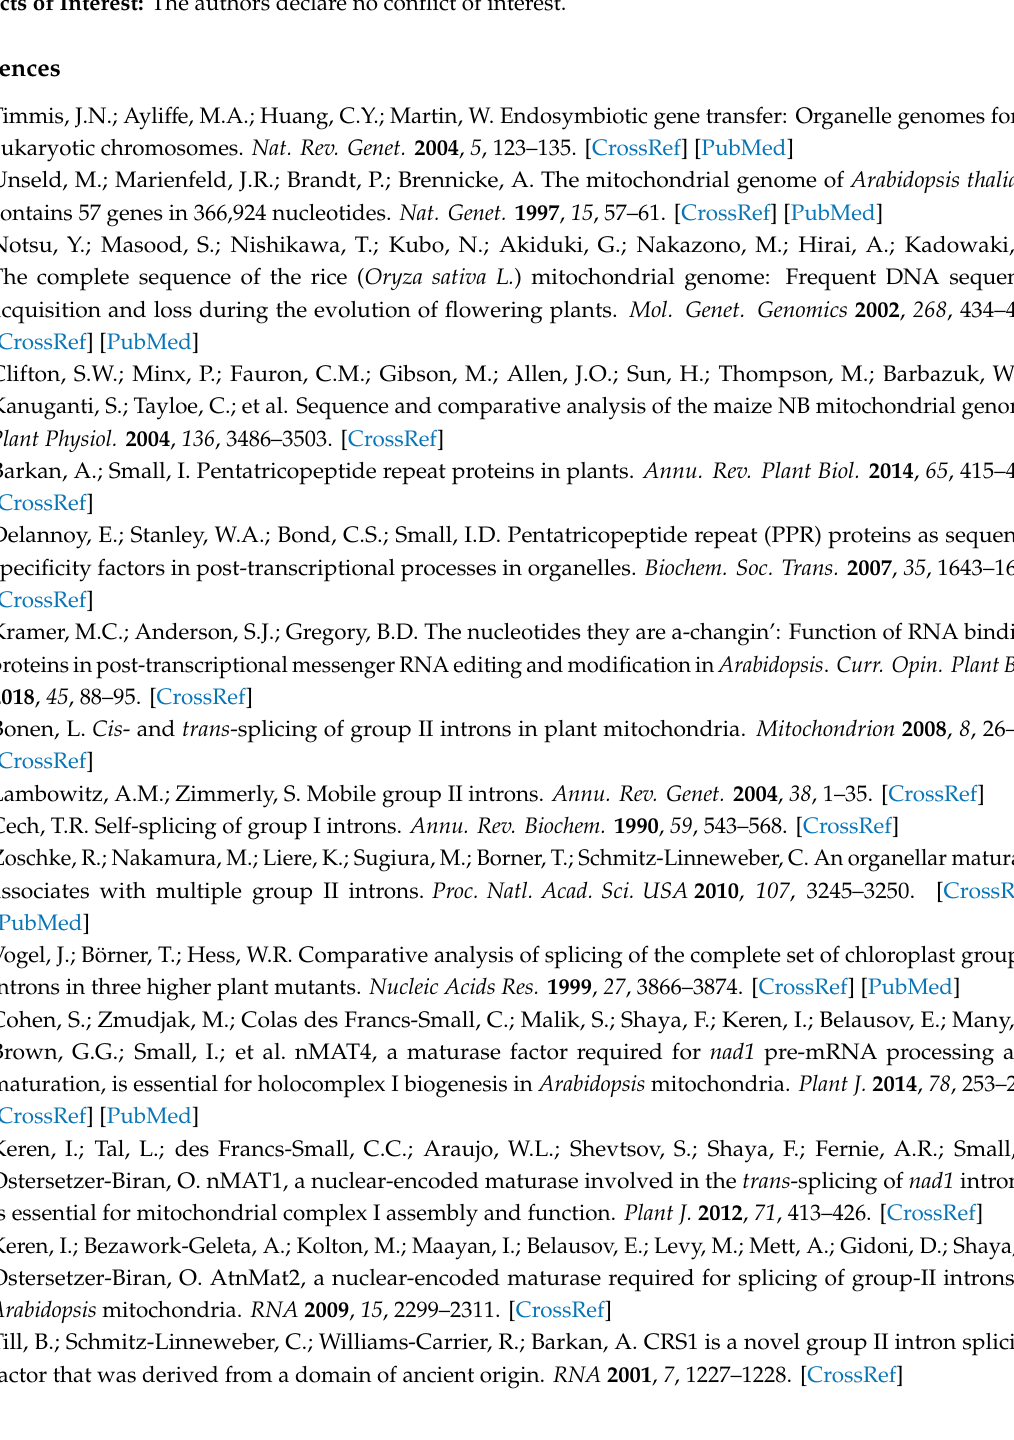
di ff erent plant species, Figure S8: Interaction assay of PPR18 and the related splicing factors, Table S1: Primers used in this